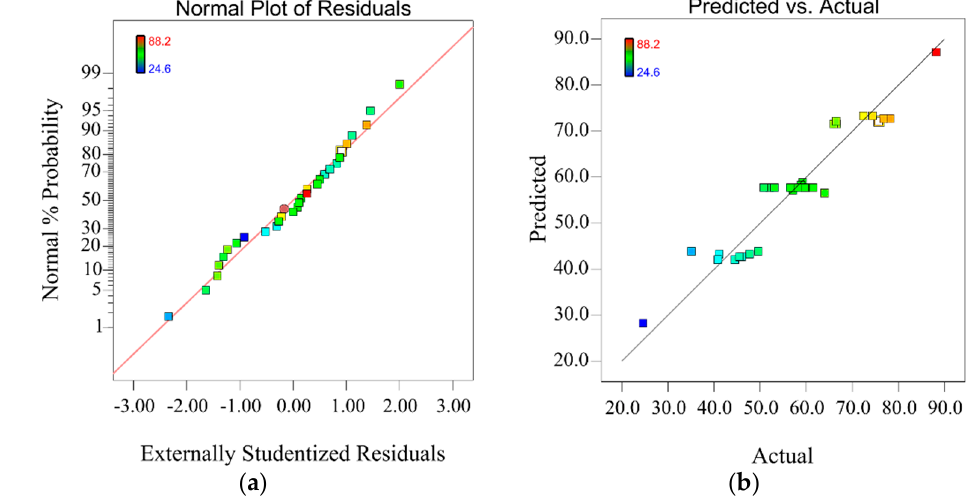
Figure 4. ( a ) Residual analysis of micro-hardness; ( b ) Micro-hardness comparison between the predicted and actual.